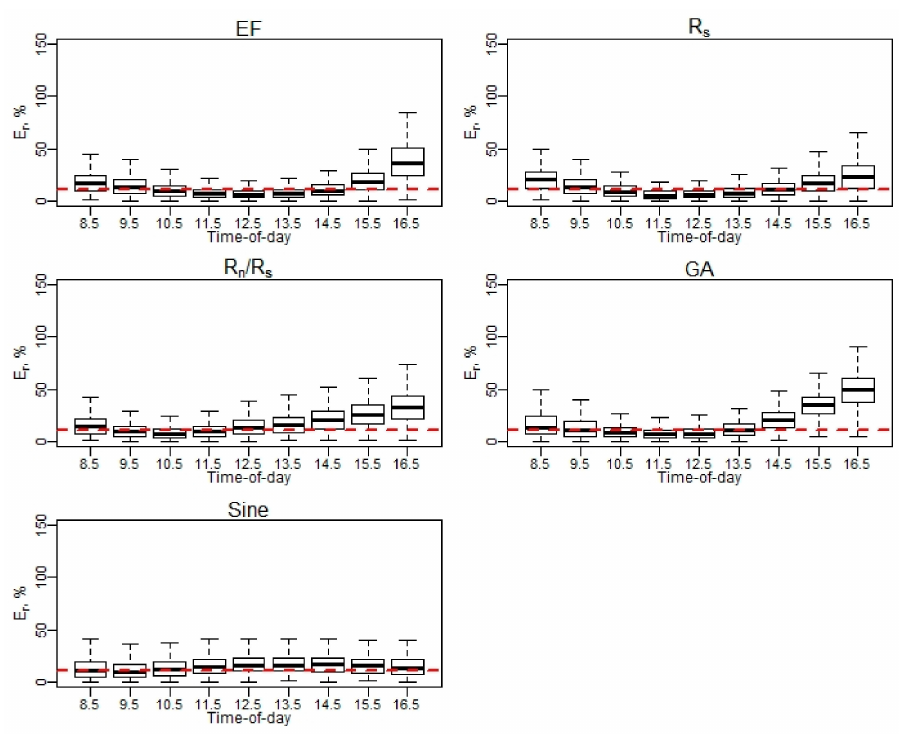
Figure A2. E r of daily EC ET